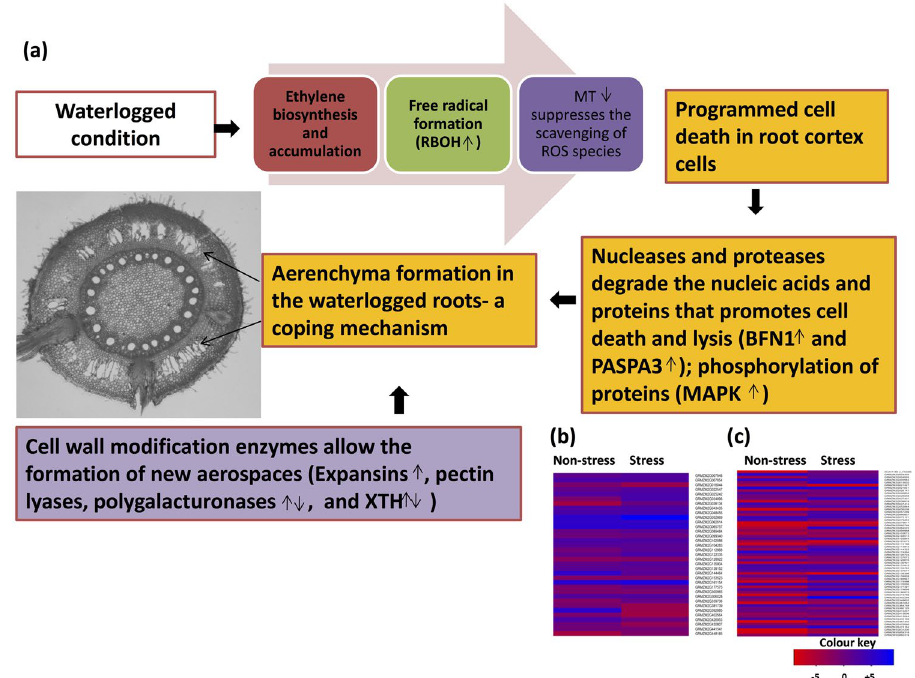
Figure 4. Programmed cell death (PCD) of root cells leading to aerenchyma formation regulated in waterlogging tolerant genotype under stressed conditions. ( a ) PCD pathway and aerenchyma formation during waterlogging stress. Here arrows denote the expression level of waterlogging responsive genes in maize roots. Expression level marked here includes greater than 2 fold change. Refer the paper for abbreviations. ( b ) Heatmap of PCD and ( c ) aerenchyma formation genes. X-axis denotes non-stress and stress conditions. Y-axis denotes the gene models. Refer Table S5 and Table S6 for details of PCD and aerenhcyma formation genes.